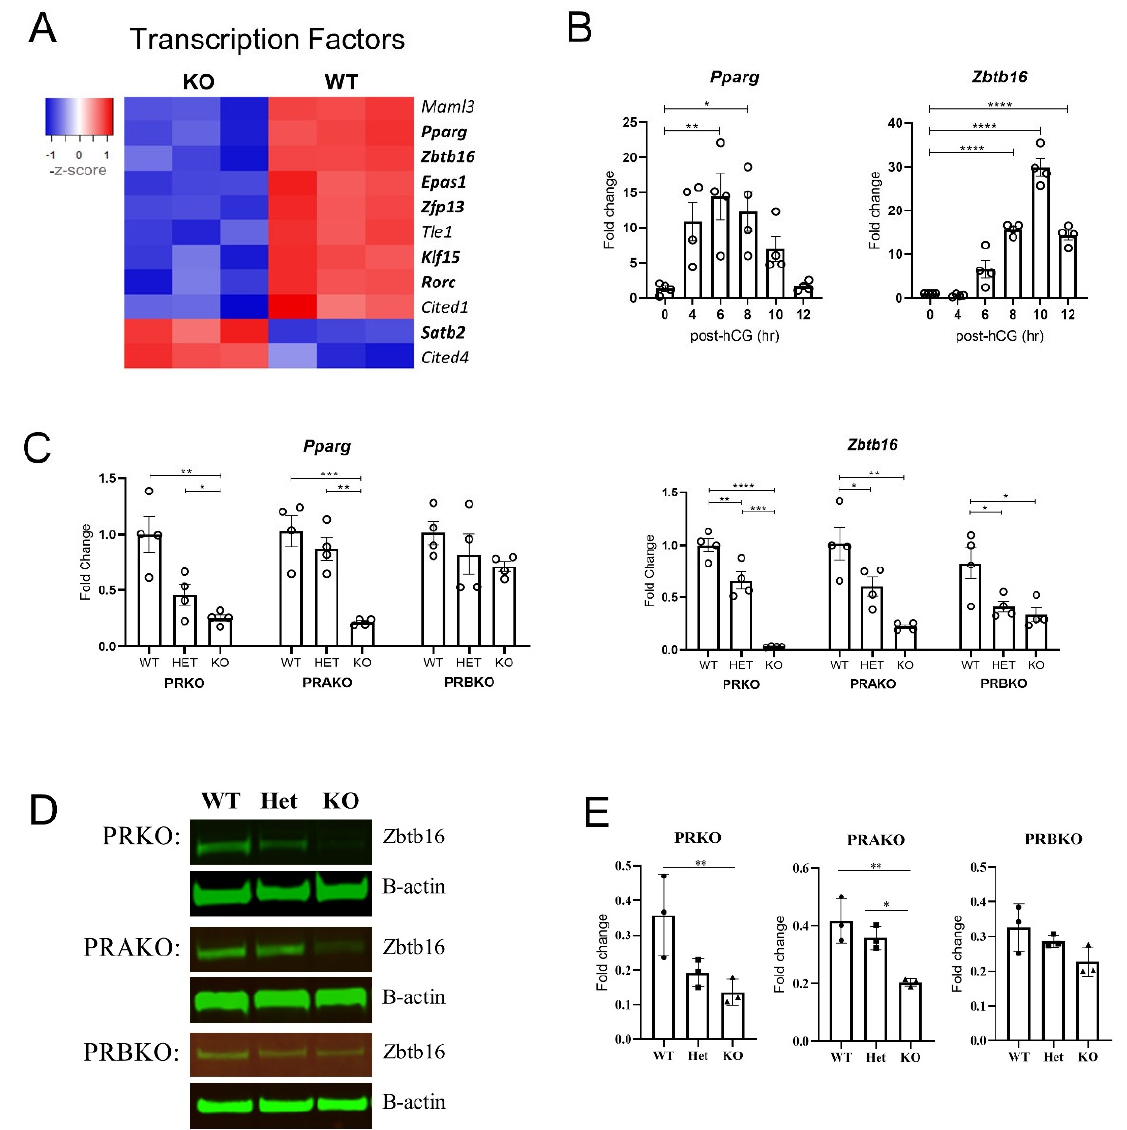
Figure 7. PGR regulates a network of transcription factors in granulosa cells including Pparg and Zbtb16 . ( A ) Heatmap showing expression level of PGR-regulated transcription factors, including DNA-binding transcription factors (bold) and transcription cofactors (not bold). Shown are PRKO (left) and PRWT (right) RNA-seq reads (LCPM) with blue representing low expression levels and red increased expression levels. ( B ) Expression of Pparg and Zbtb16 in wildtype granulosa cells over a preovulatory time course from 0–12 h post-hCG using CBA-F1 mice. ( C ) Expression of Pparg and Zbtb16 in granulosa cells of PRKO (left) PRAKO (center) and PRBKO (right) mice at 8 h post-hCG qPCR data normalized to reference gene Rpl19 and expressed as fold change relative to 0 h or WT control. N = 4 biological replicates of cells pooled from ovaries of 3 females. ( D ) Western blot for ZBTB16 protein in granulosa cells of PRKO, PRAKO and PRBKO mice at 10 h post-hCG. ( E ) Quantification of Western blot ZBTB16 expression relative to B-actin loading control. N = 3 pools of cells from 3 females. Mean ± SEM, statistical significance determined by one-way ANOVA. * p < 0.05, ** p < 0.01, *** p < 0.001, **** p < 0.0001.